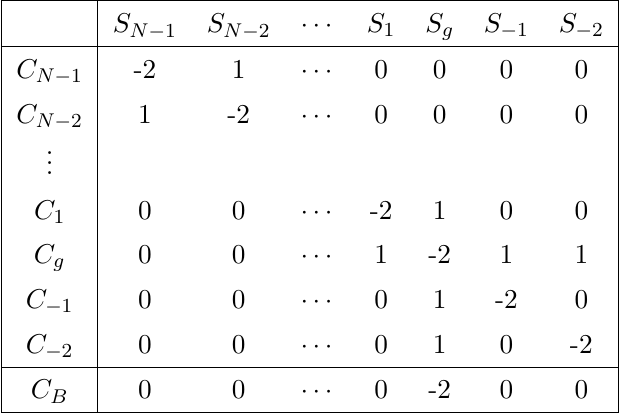
Table 2 . The intersection numbers between the surfaces S f ; f = curves C i ; i =